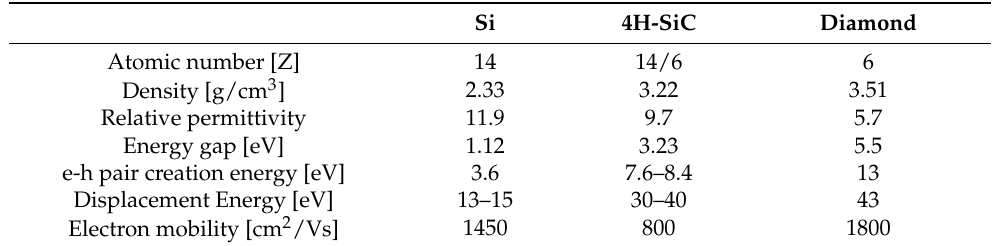
Table 1. 4H-SiC characteristics compared to Si and diamond. The table has been adapted from [19].